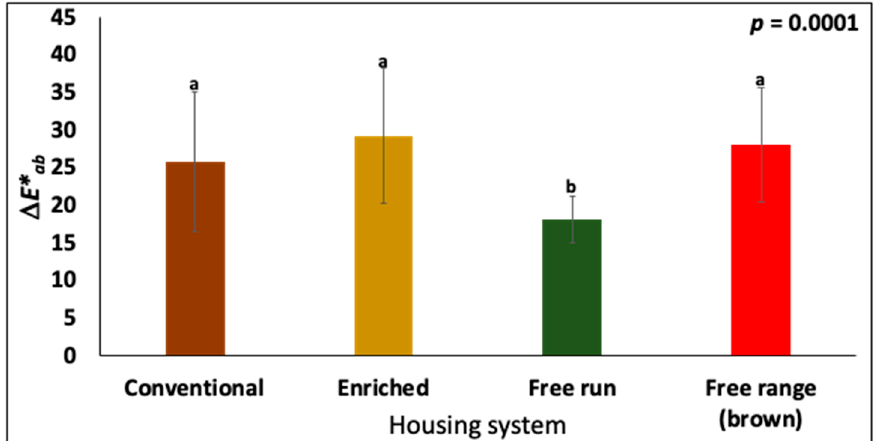
Figure 3. Δ E* ab values of eggs from hens in different housing systems. The data shown corresponds to eggs from mid-lay hens. The values represent the mean ± standard deviation from each condition ( n = 30). The values with different superscript letters (Tukey multiple means comparison) are significantly different (ANOVA; p < 0.05).